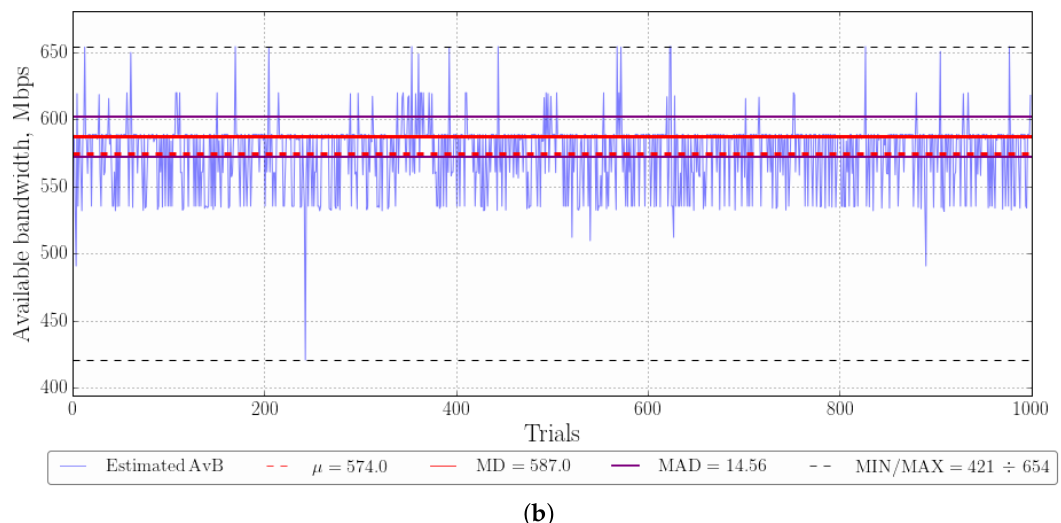
Figure 17. Yaz AvB estimation of 1 Gbps Network with 500 Mbps cross traffic: ( a ) standard system operations; and ( b ) with